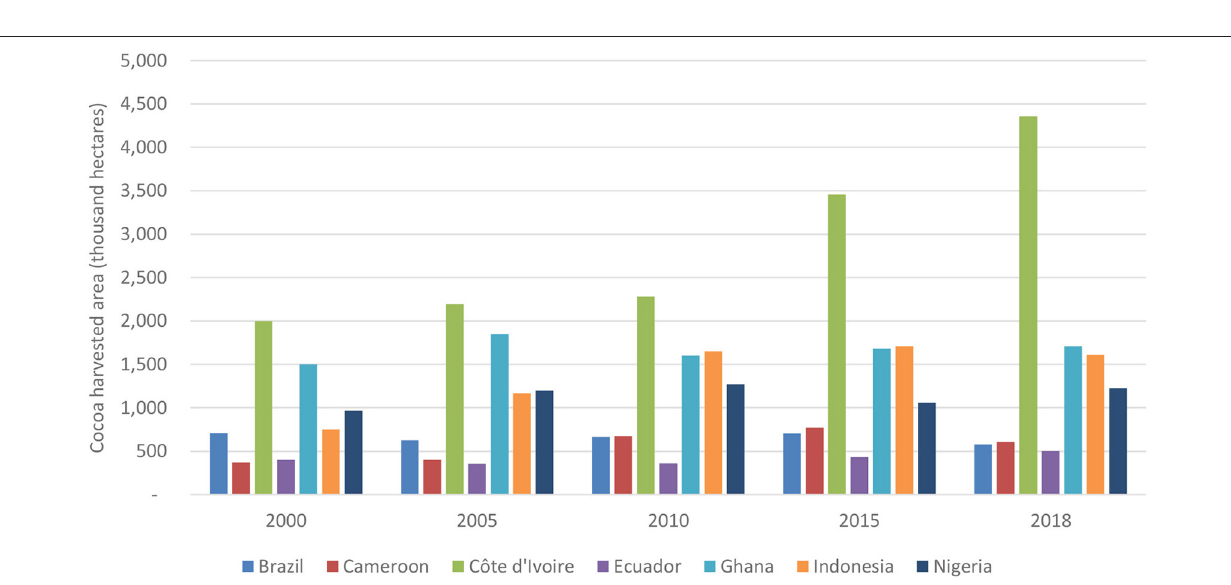
FIGURE 3 | Development of harvested areas for cocoa in major producing countries, 2000, 2005, 2010, 2015, and 2018. Source: (FAO, 2020) (processed